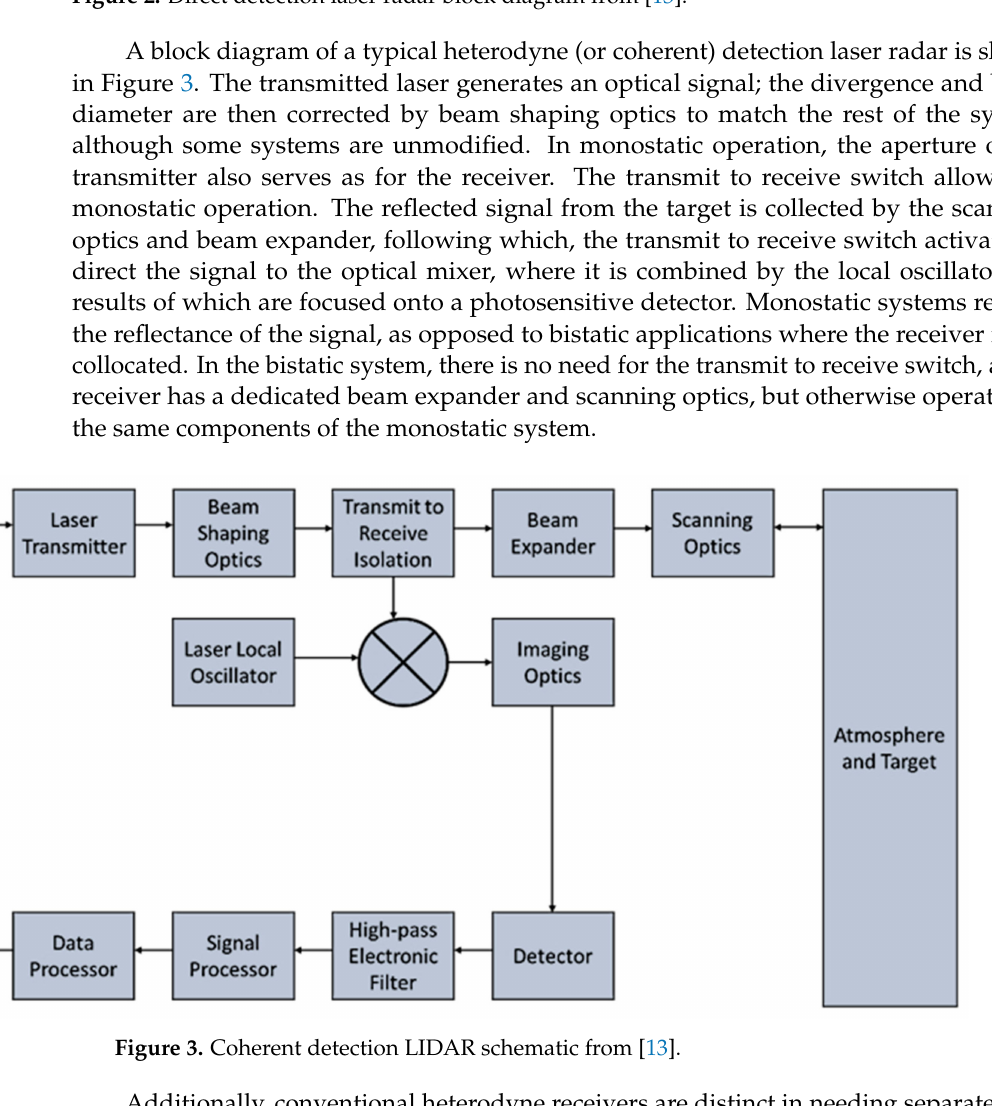
Figure 2. Direct detection laser radar block diagram from [13].